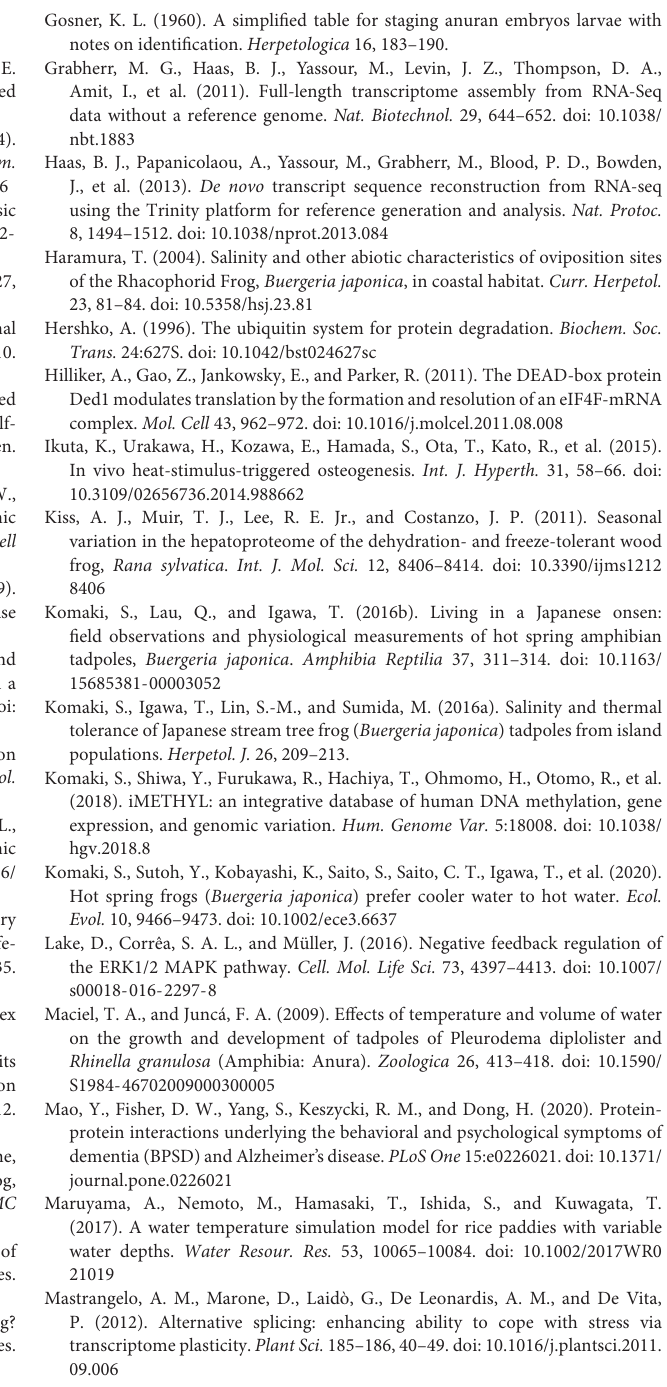
Supplementary Table 4 | Results of STRING enrichment analyses. Supplementary Text 1 | Methods and results of additional